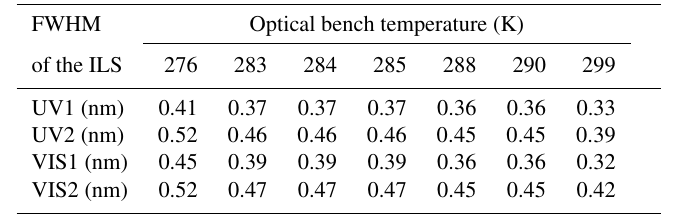
Table 5. FWHM of the ILS changes with optical bench temperature.